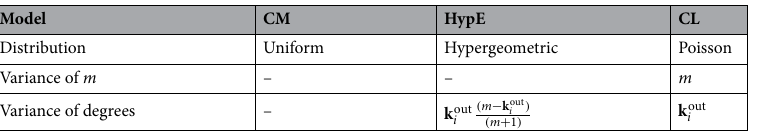
Table 1. Properties of the three configuration models CM, HypE, and CL, arranged by increasing variance in the corresponding